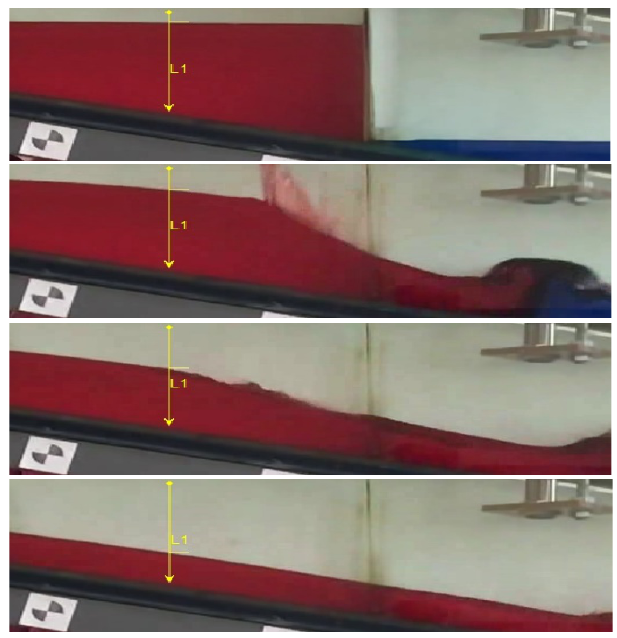
Figure 5. Water level measurement using virtual wave probe.